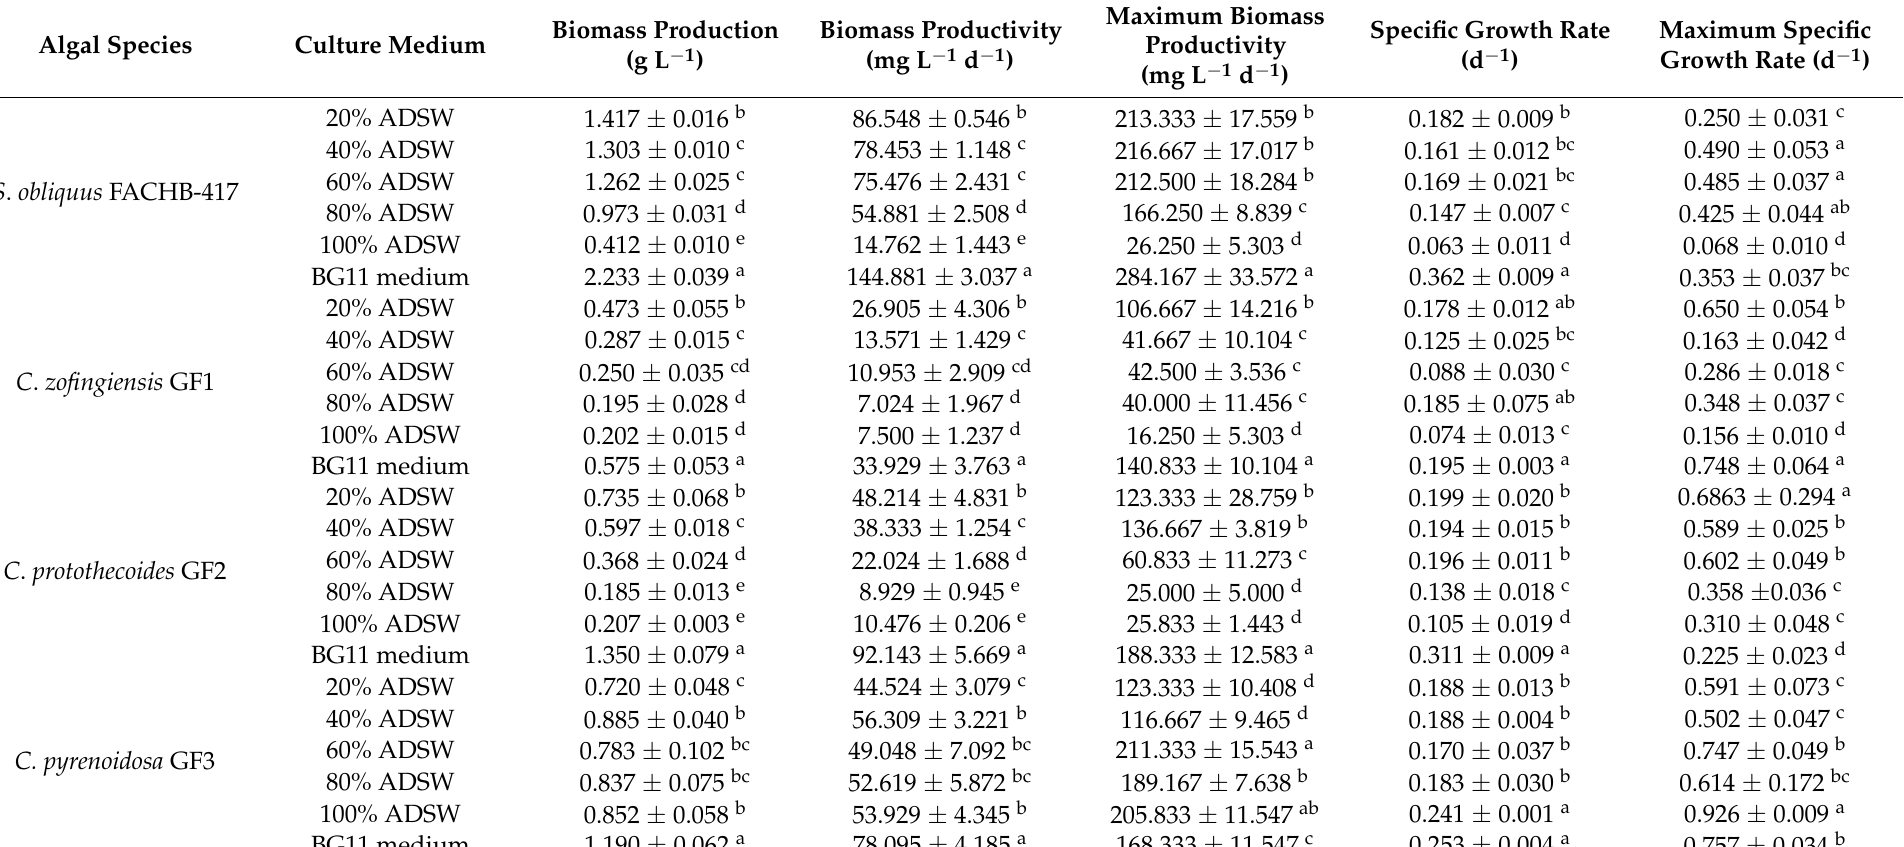
Table 2. Biomass production, biomass productivity, maximum biomass productivity, specific growth rate, maximum specific growth rate of six microalgal strains in five dilutions of ADSW and BG11 medium within 14